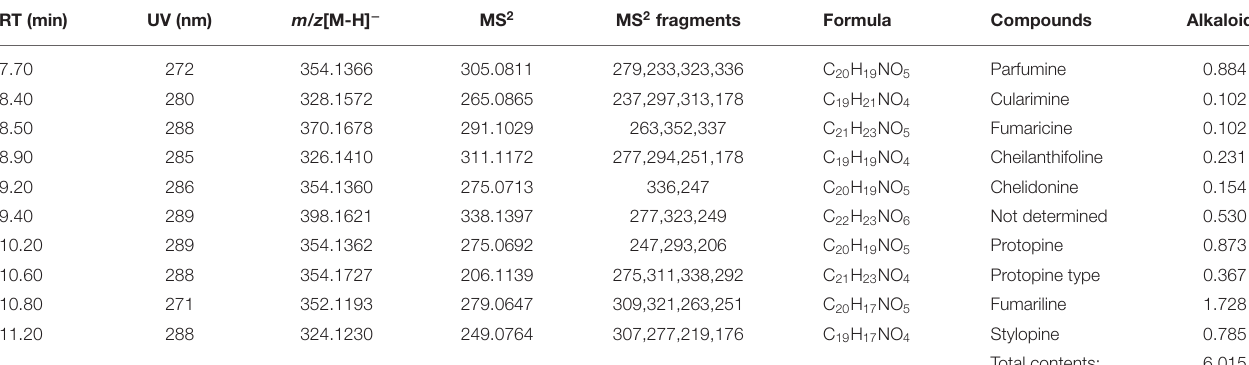
TABLE 3 | Concentrations of the main alkaloids in Fumaria officinalis (g/kg